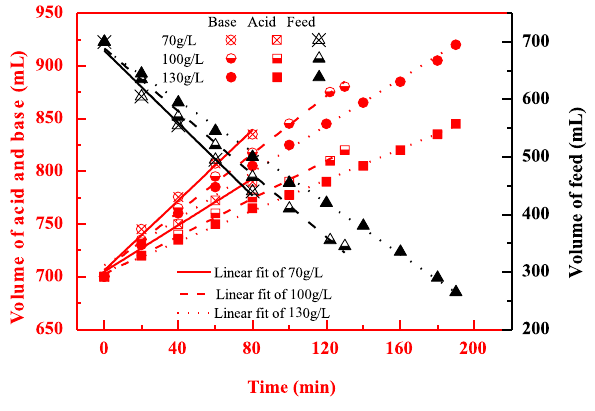
Fig. 4 Variation of solution volume in feed, acid and base compart- ments